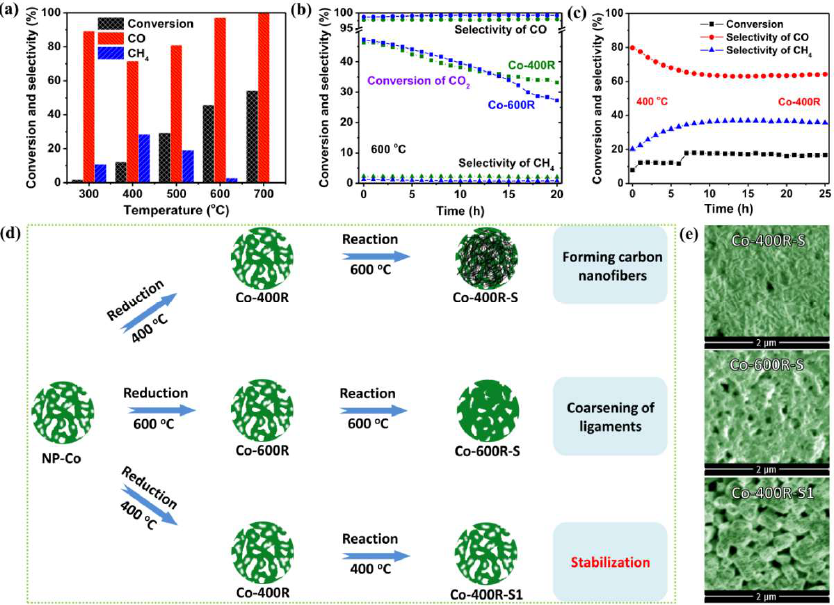
Figure 2. Catalytic performance and stability of the NP-Co catalysts in RWGS reaction. ( a ) Catalytic performance of the Co-400R catalyst at different temperature; ( b ) and ( c ) the stability of the NP-Co catalysts with different pretreatments at different temperatures (reaction conditions: Atmospheric pressure, H 2 /CO 2 = 1:1, weight hourly space velocity (WHSV) = 300,000 mL/g/h); ( d ) illustration of the NP-Co catalysts structure changes in pretreatment and reaction; ( e ) SEM images of the recycled NP-Co catalysts.